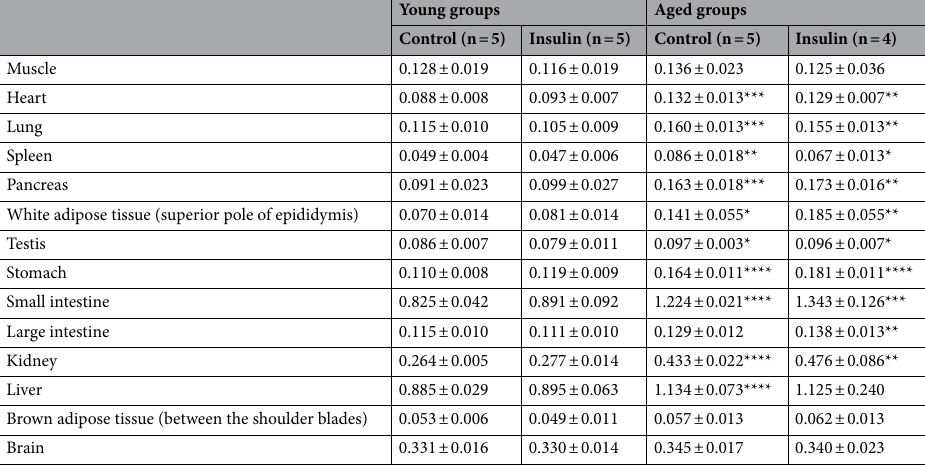
Table 2. Weights of organs in mice (g). Data in parentheses are mean ± SD. Control, control group; Insulin, insulin-loaded group. * P < 0.05, ** P < 0.01, *** P < 0.001, **** P < 0.0001 vs young groups in control and insulin- loaded